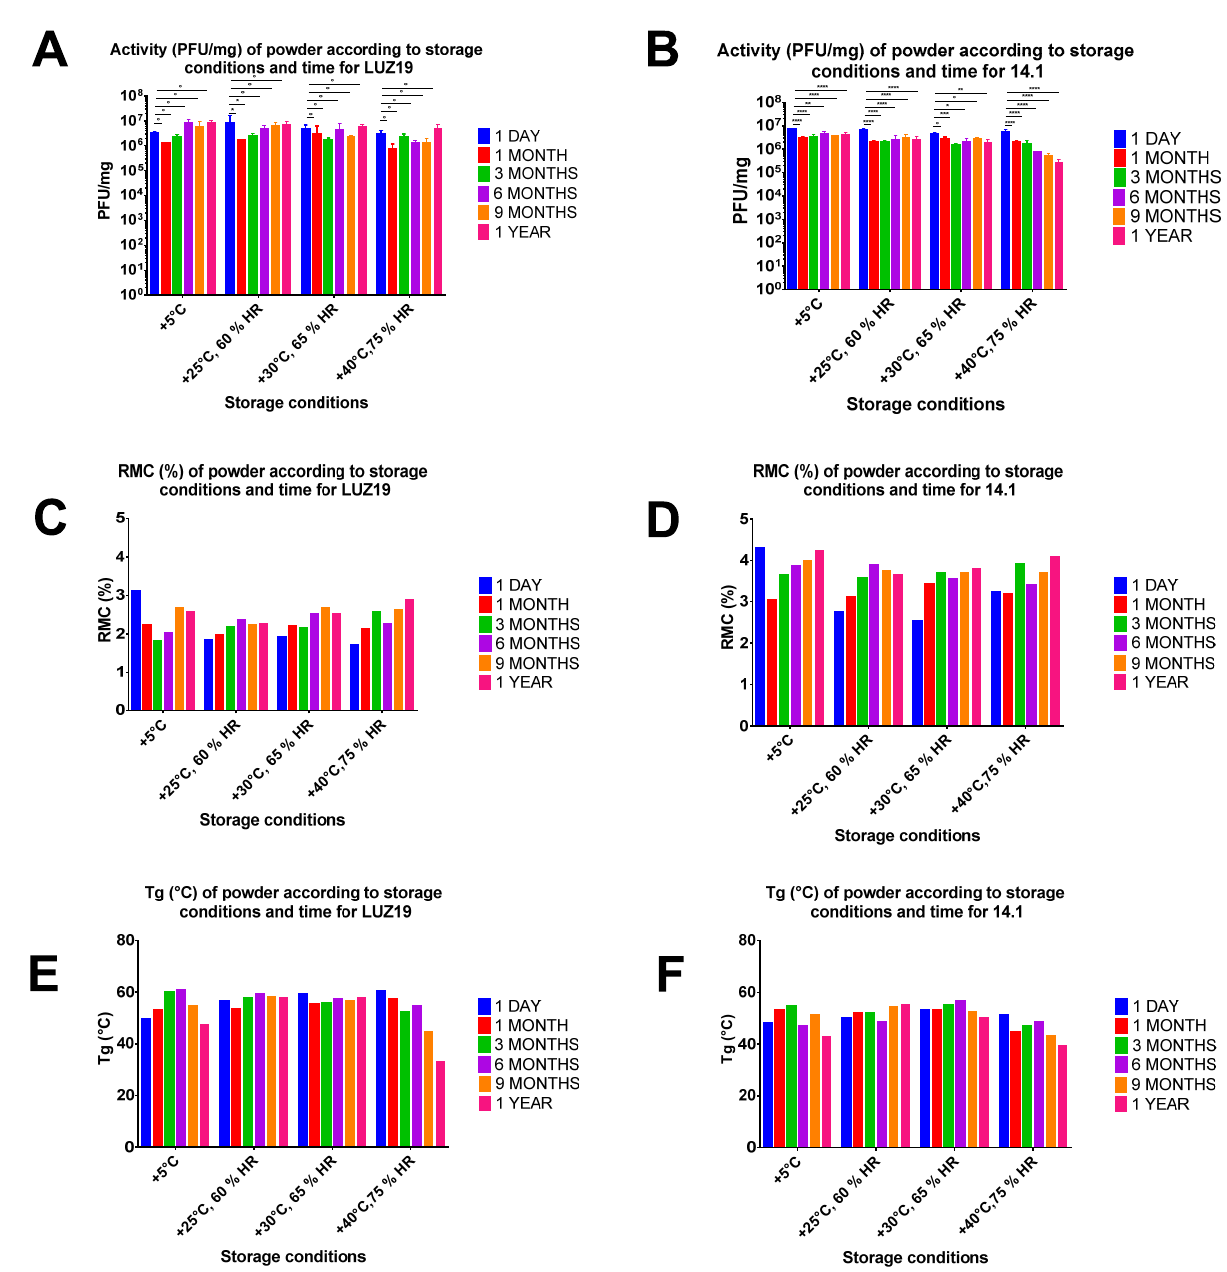
Figure 9. Evolution of bacteriophage activity (pfu/mg) in the optimized spray ‐ dried powders containing LUZ19 ( A ) and 14 ‐ 1 ( B ), as well as RMC (%) and Tg (°C) evolution over time for optimized spray ‐ dried powders containing LUZ19 ( C , E ) and 14 ‐ 1 ( D , F ) under different storage conditions for up to one year. A Dunnett’s multiple comparisons test was used for the statistical analysis. °, p > 0.05; *, p < 0.05; **, p < 0.005; ***, p < 0.0005; ****, p = 0.0001.